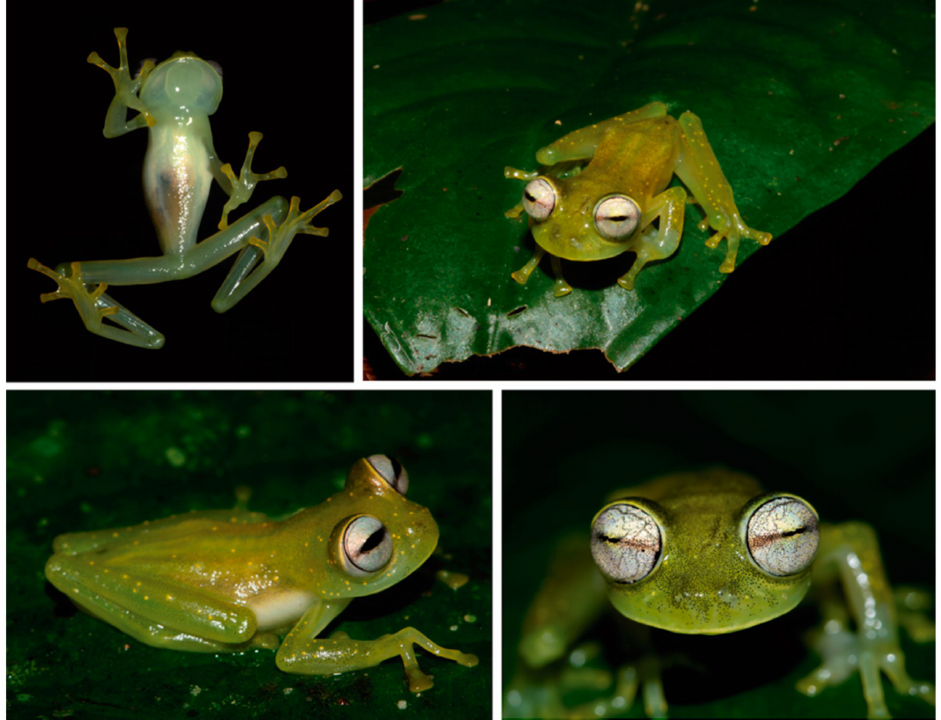
Figure 146. Nymphargus chancas in life from 5.9 km SE from the type locality of Abra Tangarana, San Mart í n, 6 ◦ 19 (cid:48) 15.65” S 76 ◦ 41 (cid:48) 44.16” W, 973 m, CORBIDI 10471. Photos by Jesse Delia ( upper row ) and Evan Twomey ( lower row